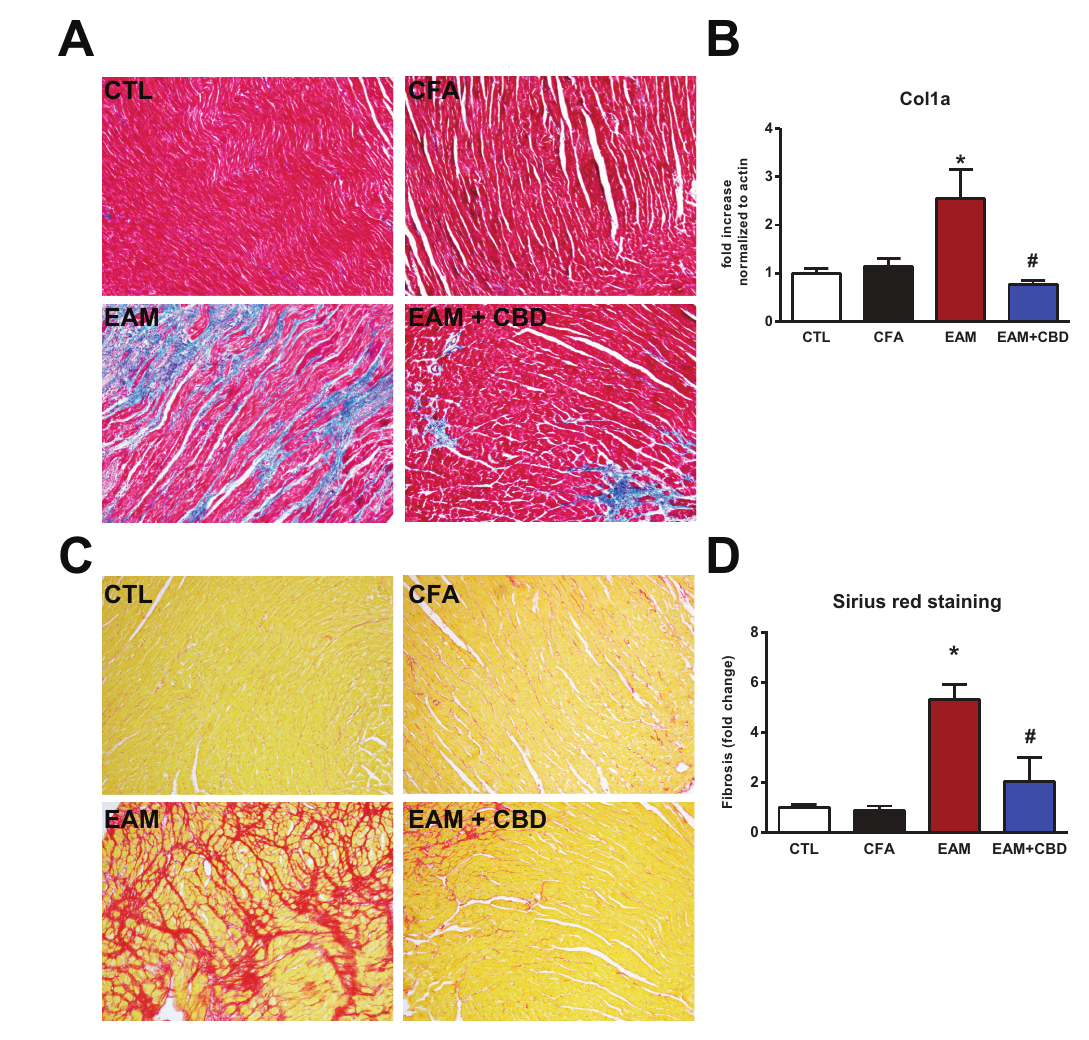
Figure 5. Effects of CBD on myocardial fibrotic remodeling induced by EAM. (A) Representative images of Masson trichrome–stained LV myocardial sections. Magnification: 100×. (B) LV mRNA expression of collagen 1 α (Col1a). (C) Representative images of Sirius red– stained LV myocardium sections. Magnification: 100×. (D) Quantification of Sirius red positive area in LV myocardium. * P < 0.05 versus CTL; # P < 0.05 versus